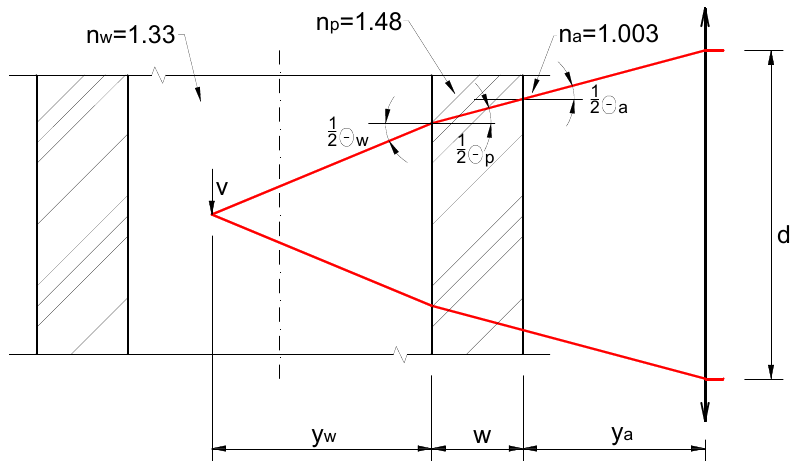
Figure 5. A course of the laser rays from the optics to a measurement point.